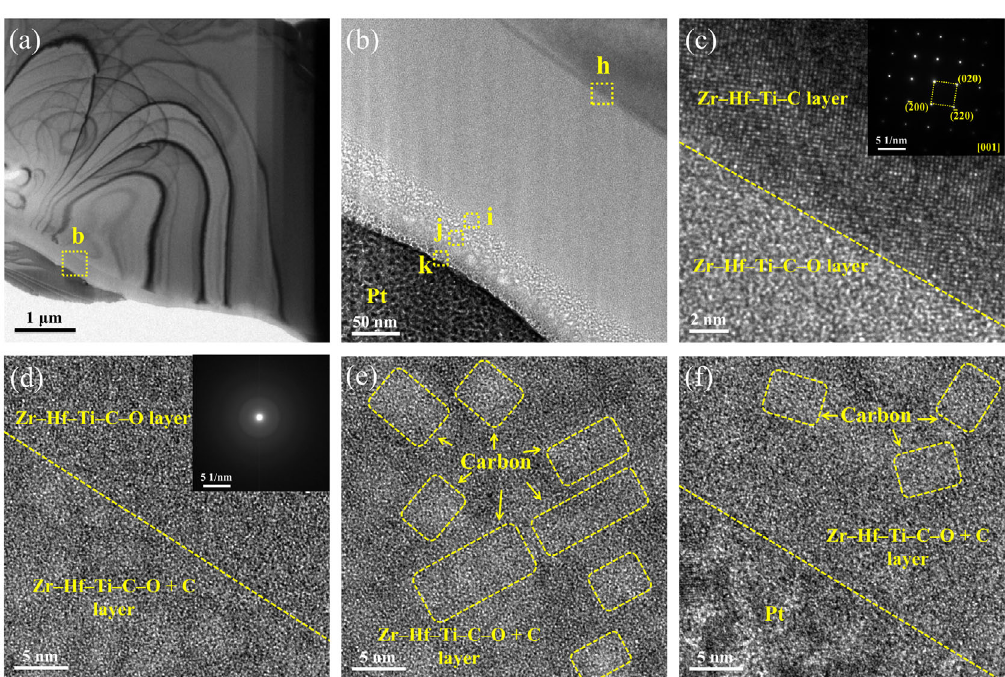
Fig. 10 TEM observations of the Zr 1/3 Hf 1/3 Ti 1/3 C 0.8 after being oxidized at 500 ℃ for 1 h in air: (a, b) TEM images and (c–f) HRTEM images of zones h–k in (b), respectively. The insets of (c) and (d) are the corresponding SAED